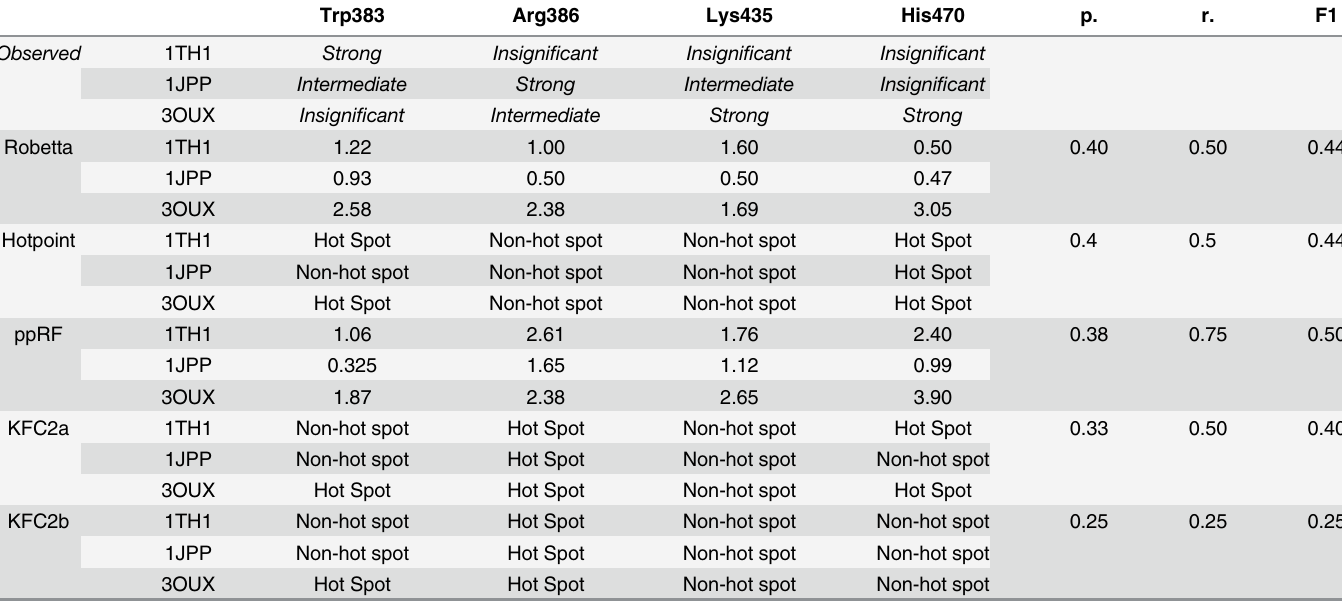
Table 1. Binding hot spot residues unique to the three complexes in Fig 1. The numeric real numbers are predicted values of ΔΔ G (kcal/mol). The Observed rows provide the BID-labels in the previous work [35].p.: precision; r. recall.